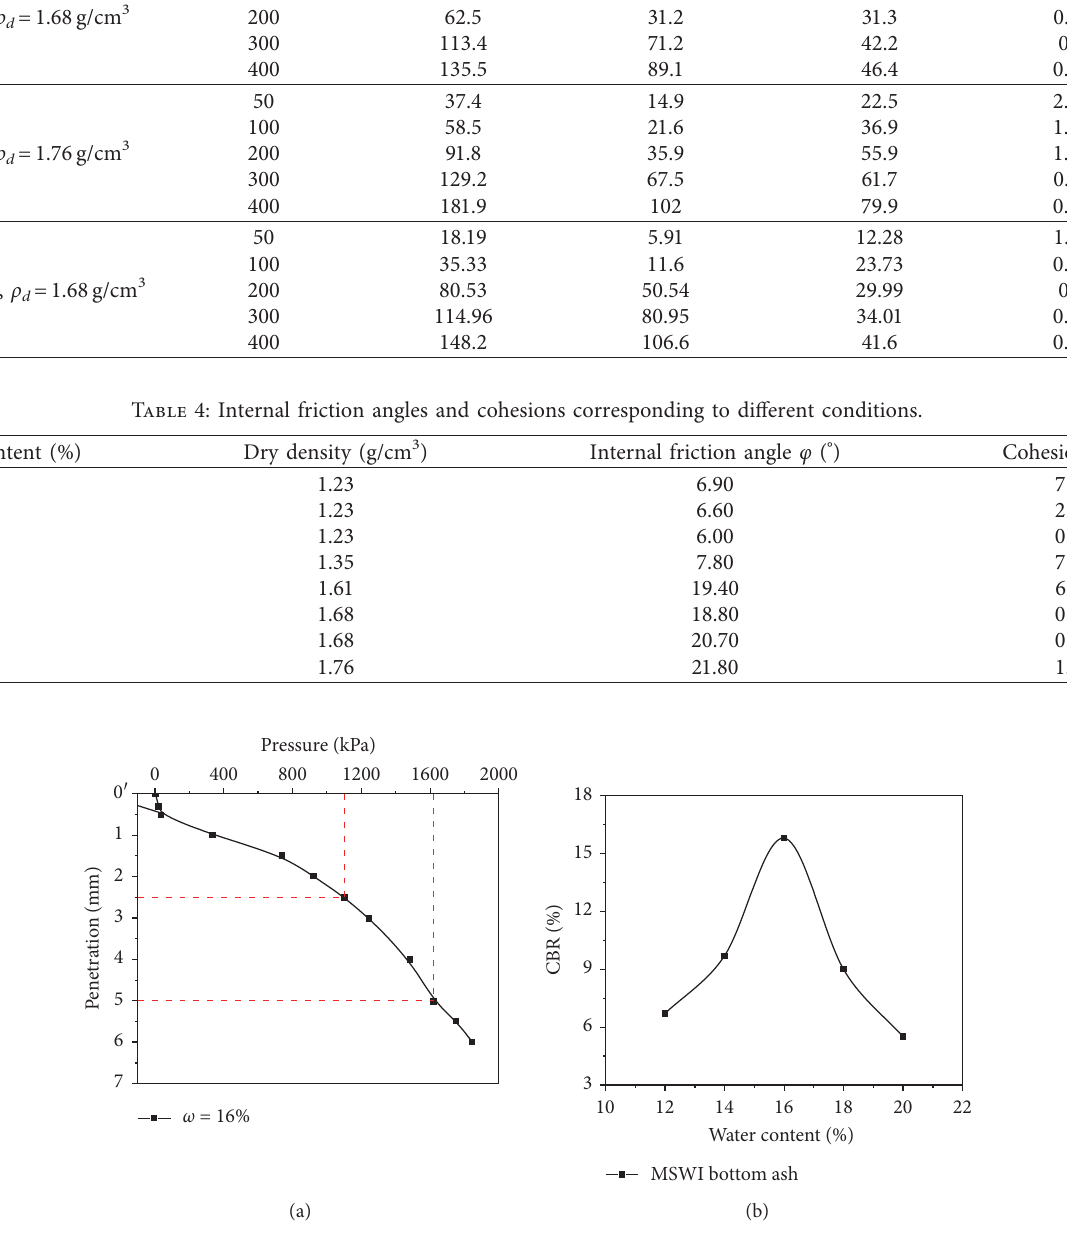
Figure 10: Penetration at water content of 16% and CBR at different water